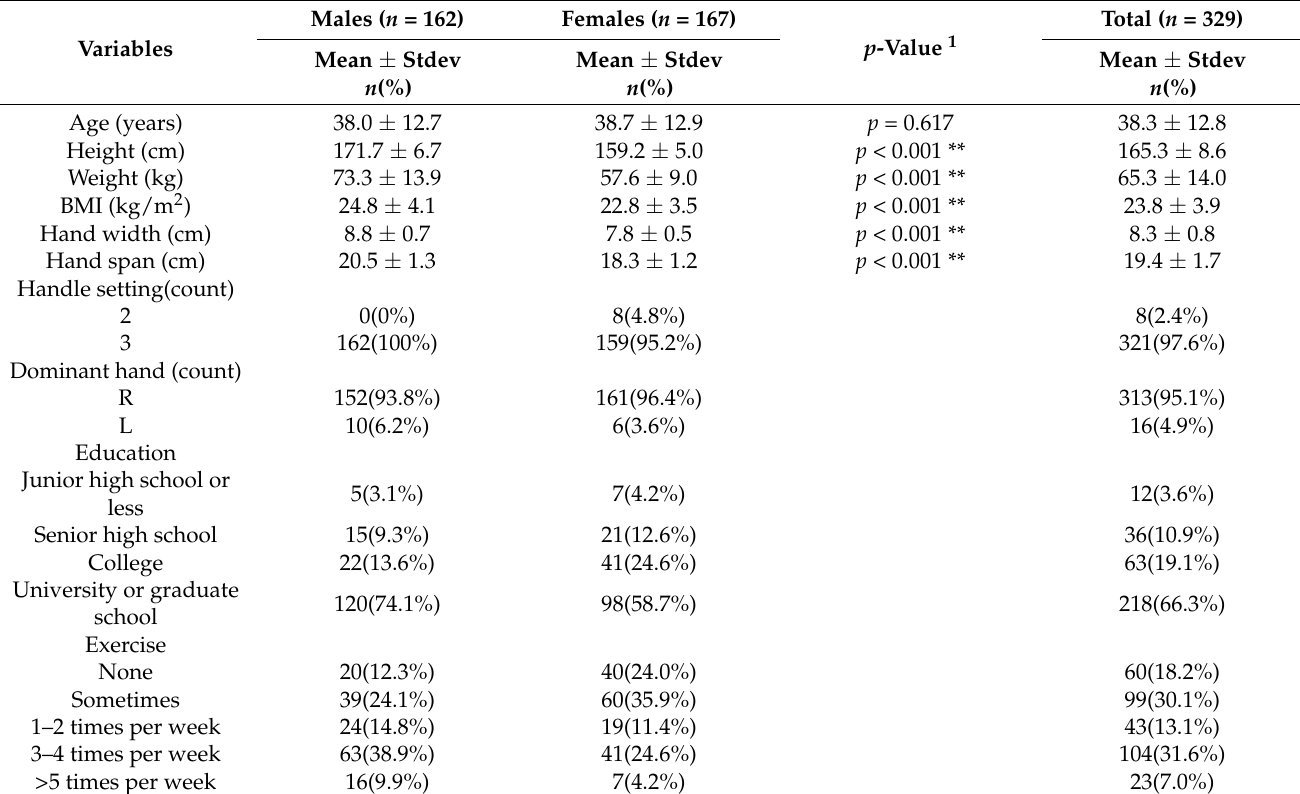
Table 1. Demographic information of the subjects in the healthcare industry ( n =